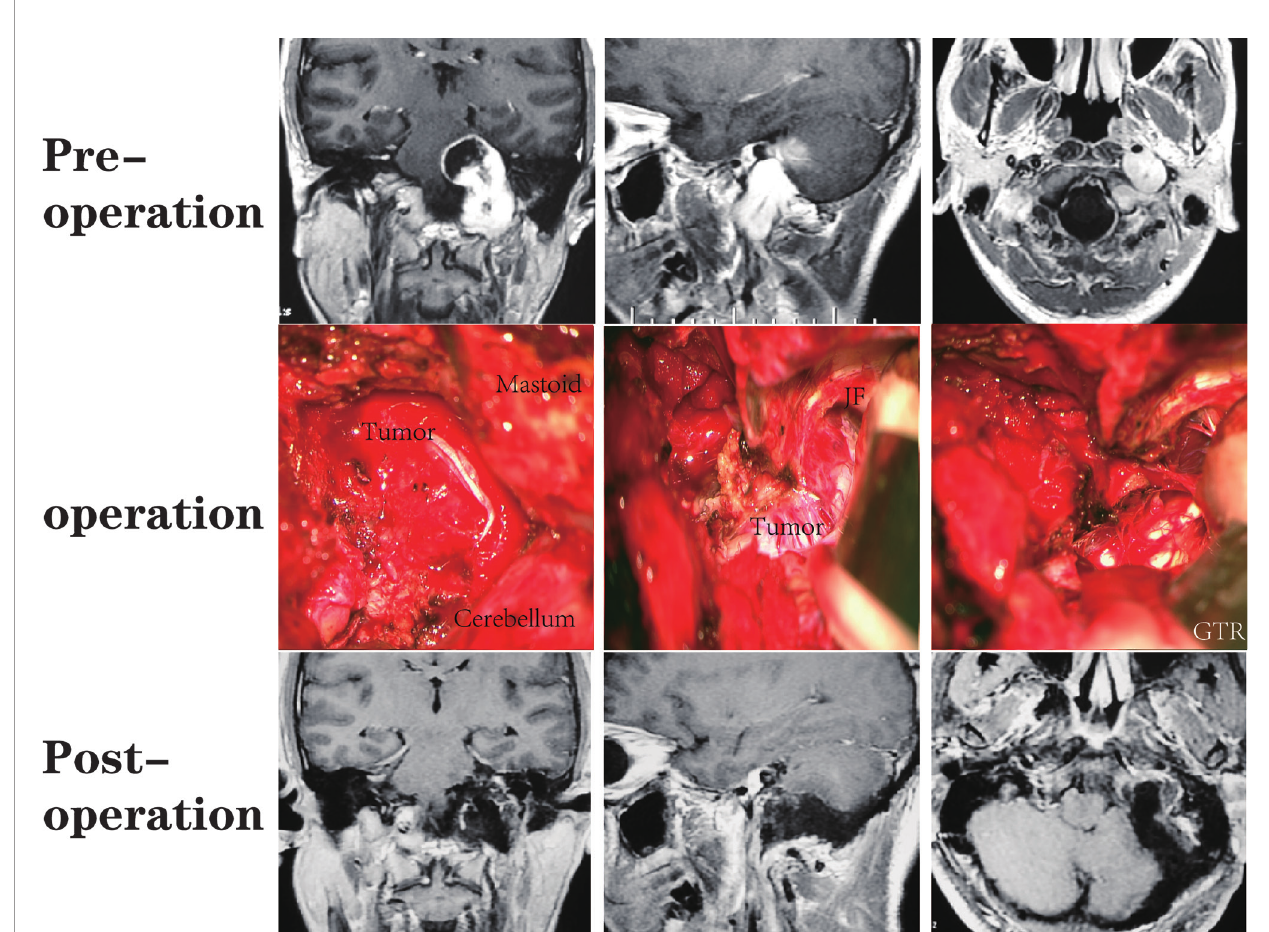
FIGURE 5 | A patient with a JFS who underwent suboccipital paracondylar-lateral cervical approach. The jugular foramen was opened posteriorly by removing the jugular process. The parapharyngeal tumor was removed fi rst, followed by the foramen and the intracranial